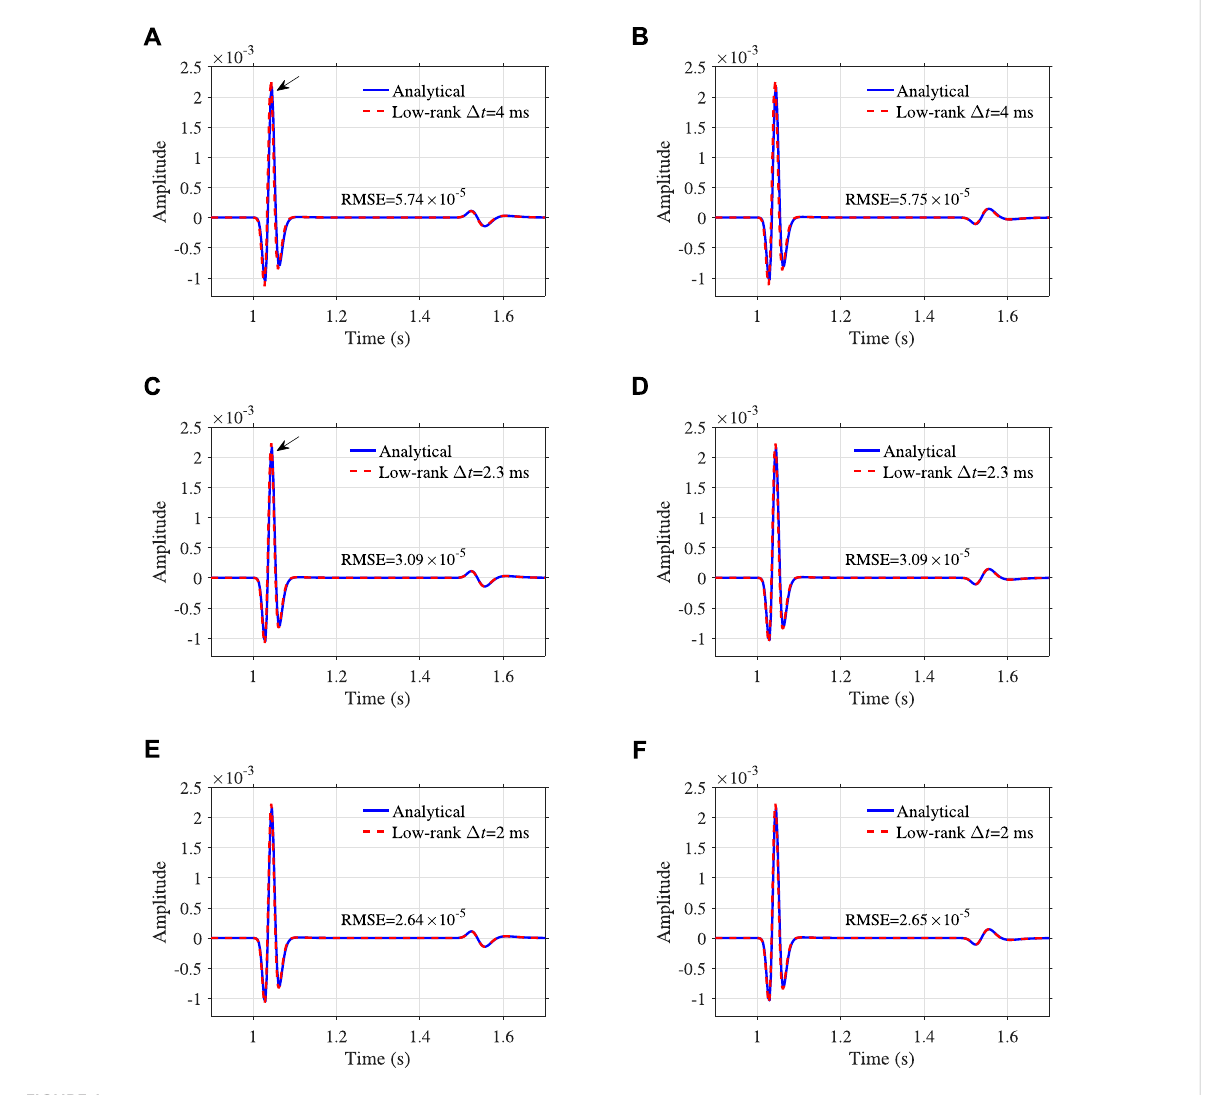
FIGURE 1 Comparison oflow-rank numerical solutionswith analyticalsolutionswhere (A, C, E) depict v x , (B,D,F) show v z . The timestepping sizesused for thelow-ranktemporalextrapolationaremarkedinthepanels.Thearrowsin (A,C) markslightamplitudedifferencescausedbytheapproximationsin Eqs 16, 29. The abbreviation RMSE represents the root-mean-square